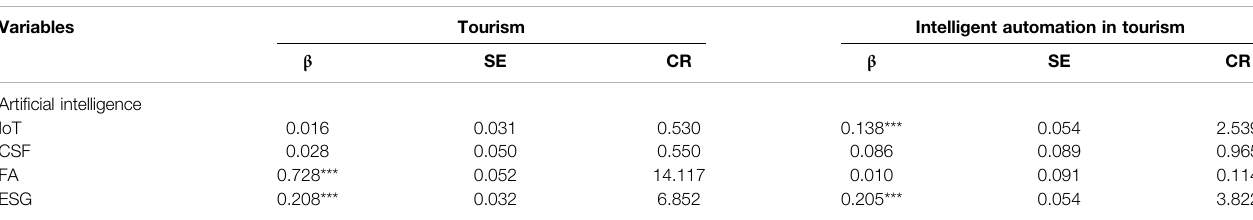
TABLE 3 | Standardized estimates of indirect effects of the paths for intelligent automation in tourism ( N = 402). Variables